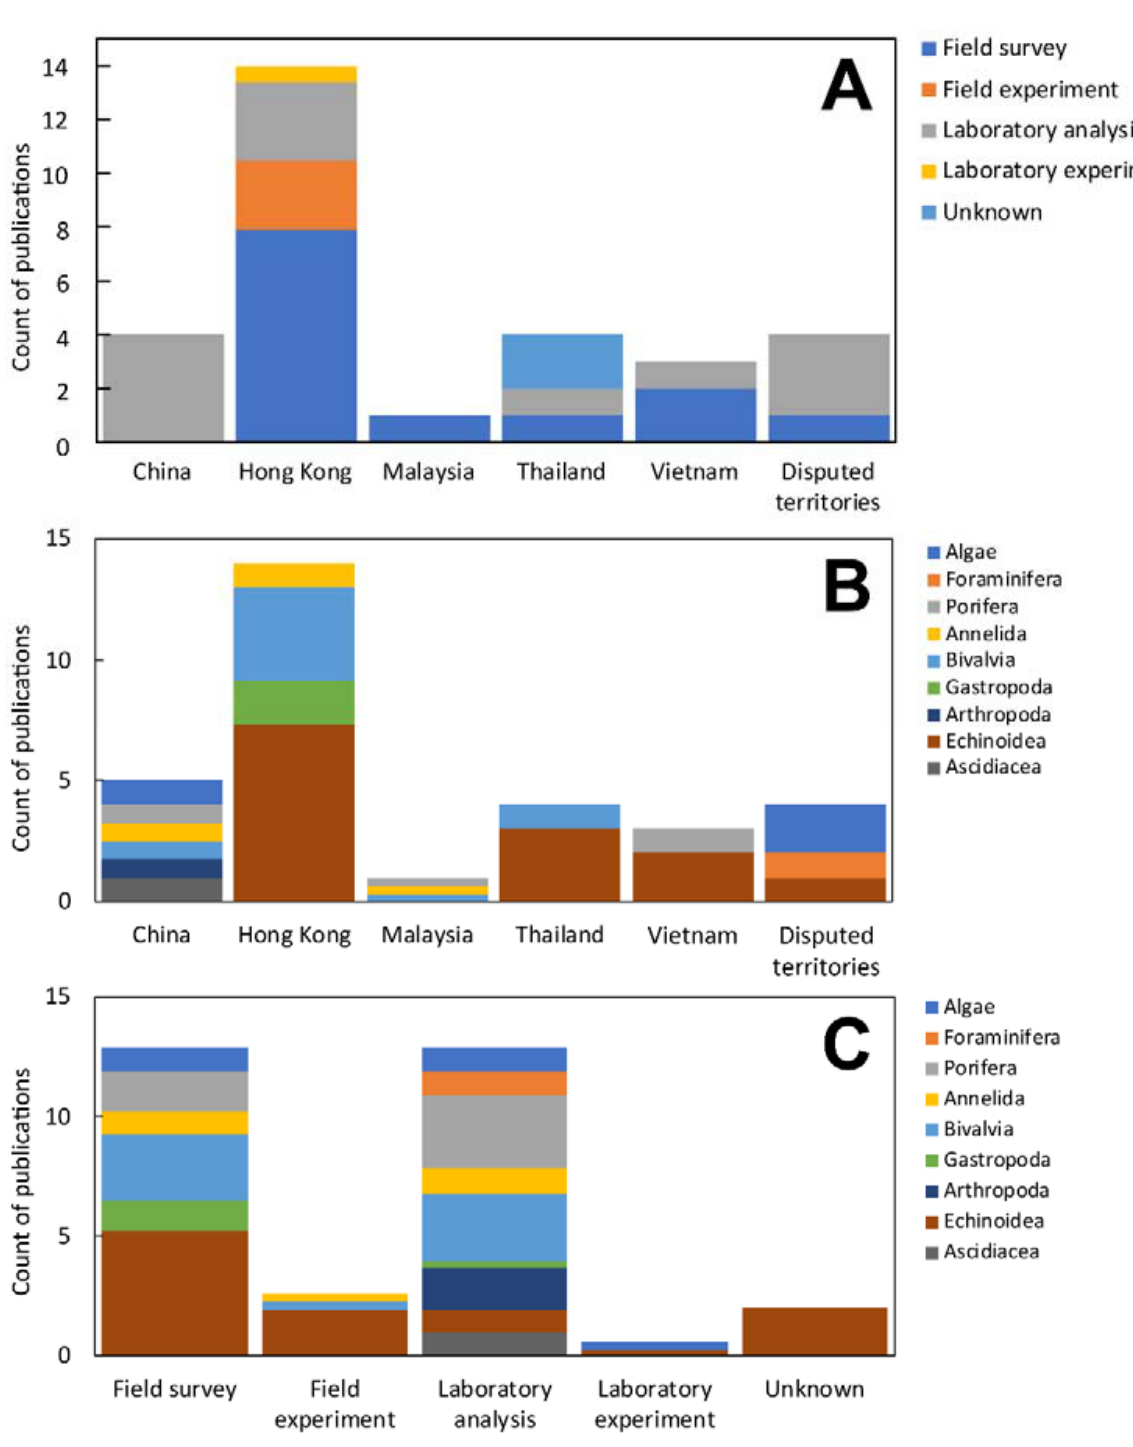
Figure 4. Cross-referenced data on proportional research on bioeroders in the South China Sea. ( A ) Approach of study in different countries. ( B ) Taxa studied in different countries. ( C ) Approach of study for different taxa.